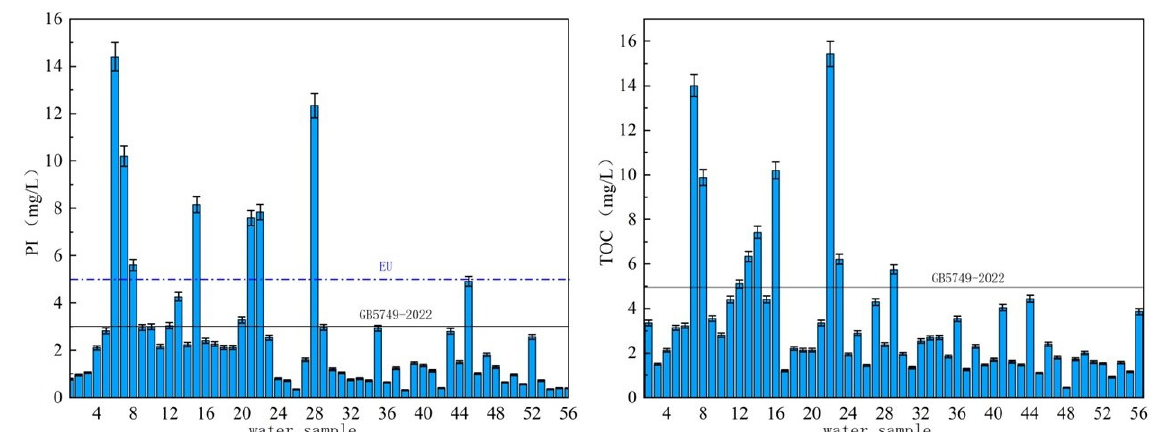
Figure 10. Oxygen consumption and TOC